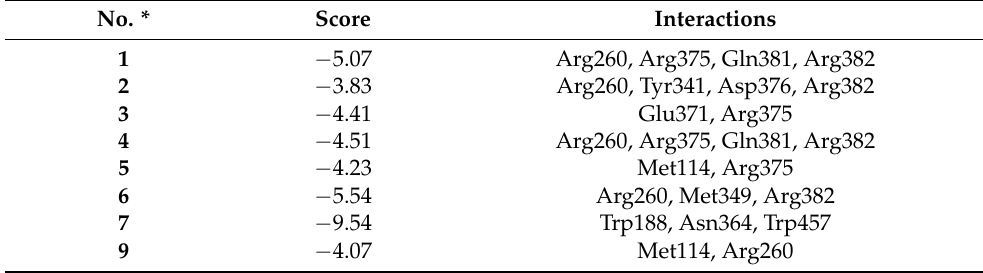
Table 4. Docking scores (kcal/mol) and interactions of E. divinorum metabolites in the active site of inducible nitric oxide synthase